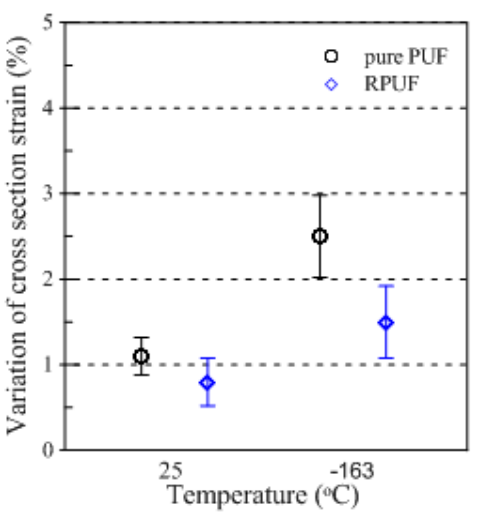
Figure 9. Variation in the cross-section of the rigid PUF specimen according to the compressive test method.